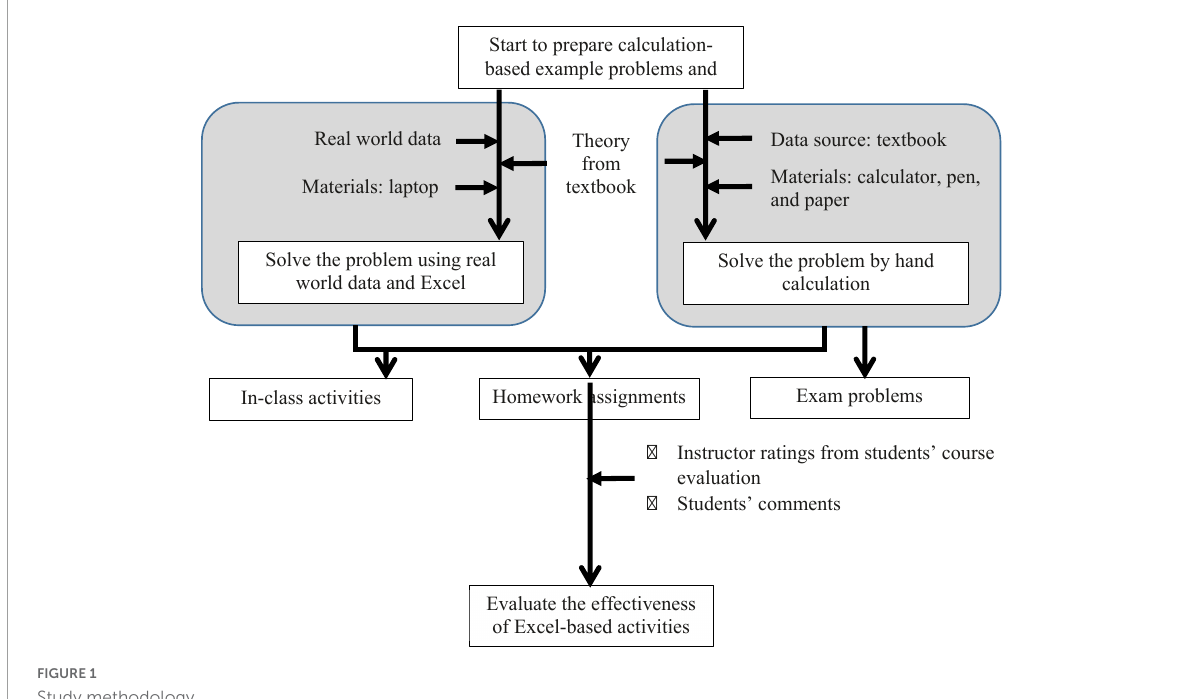
FIGURE1 Study methodology.